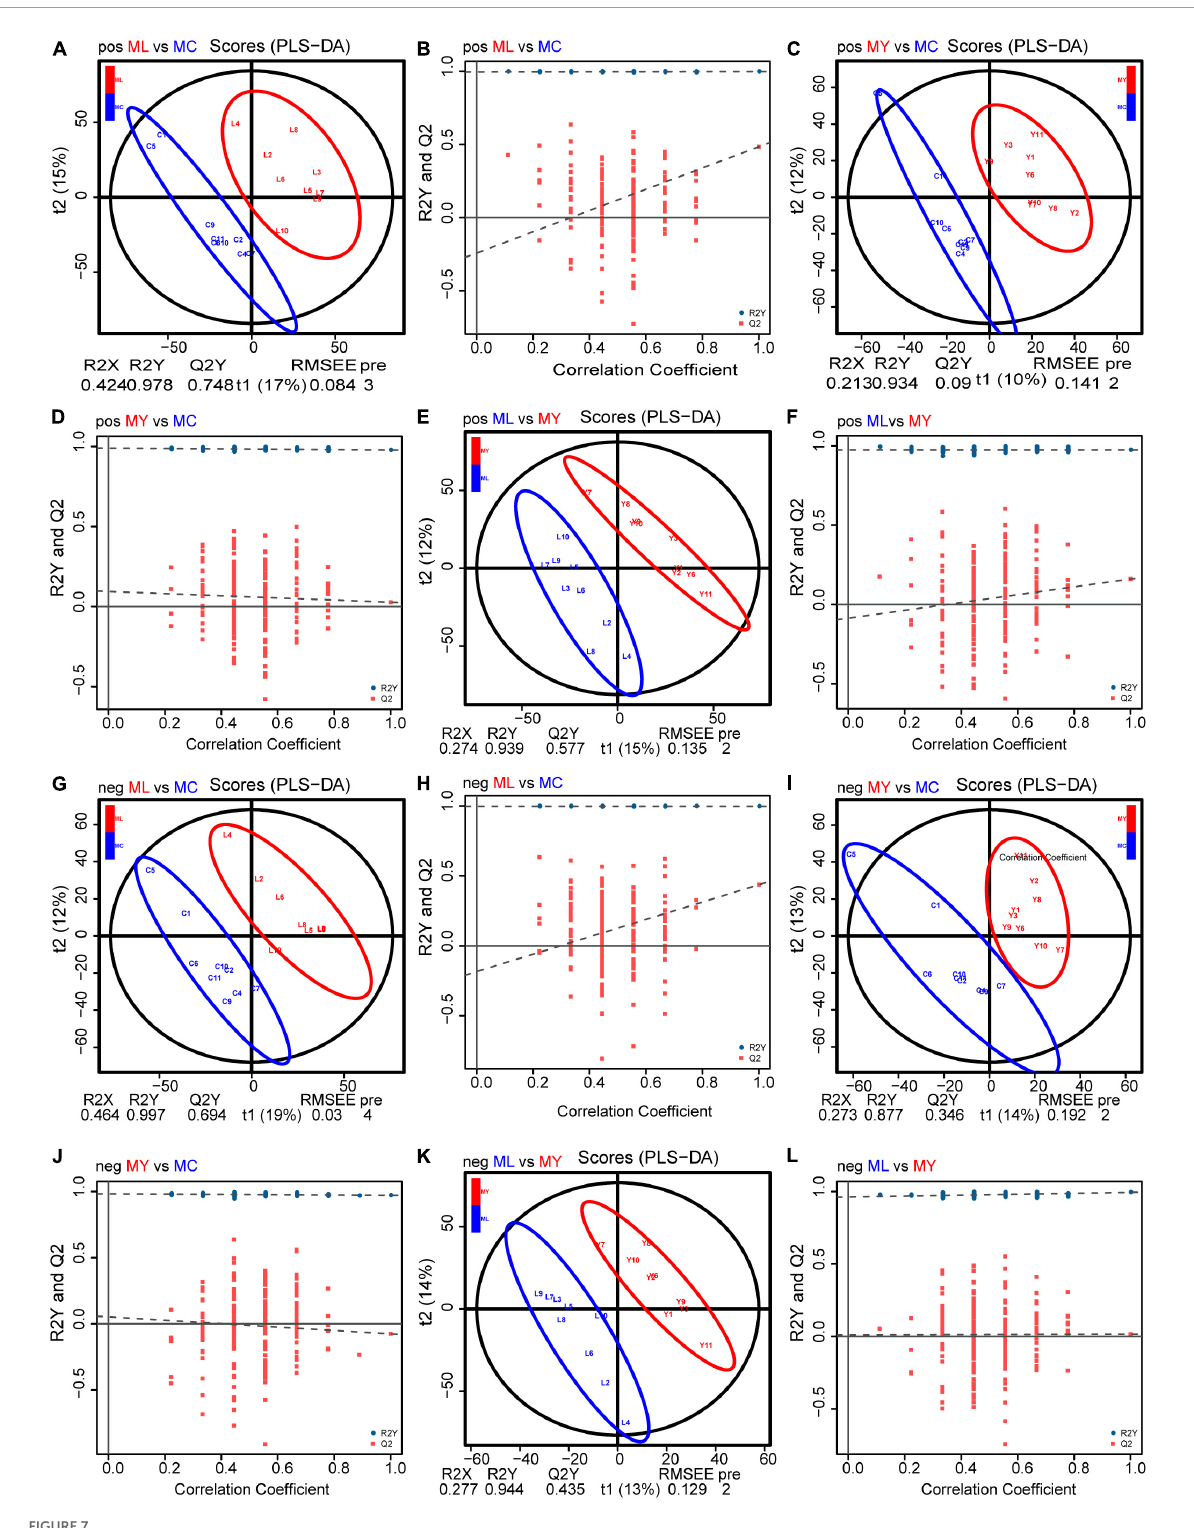
FIGURE7 Orthogonal partial least squares discriminant analysis (OPLS–DA) plot and response permutation testing (RPT) of rumen metabolites. POS (positive ionization mode): (A,B) for ML vs MC; (C,D) for MY vs MC; (E,F) for ML vs MY. NEG (negative ionization mode): (G,H) for ML vs MC; (I,J) for MY vs MC; (K,L) for ML vs MY. R2Y and Q2 indicates the cumulative interpretation power and predictive power of the model, respectively. MC, control group ( n = 9); ML, active dry yeast group ( n = 9); MY, yeast culture group ( n =